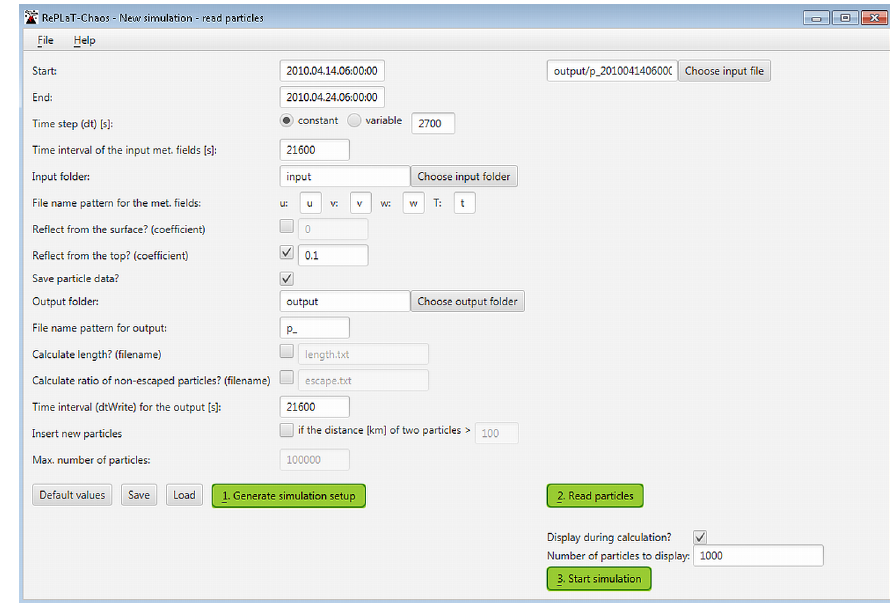
Figure A2. New simulation - read particles. Starting a new simulation by setting the parameters of the simulation and reading the particles of the pollutant clouds from